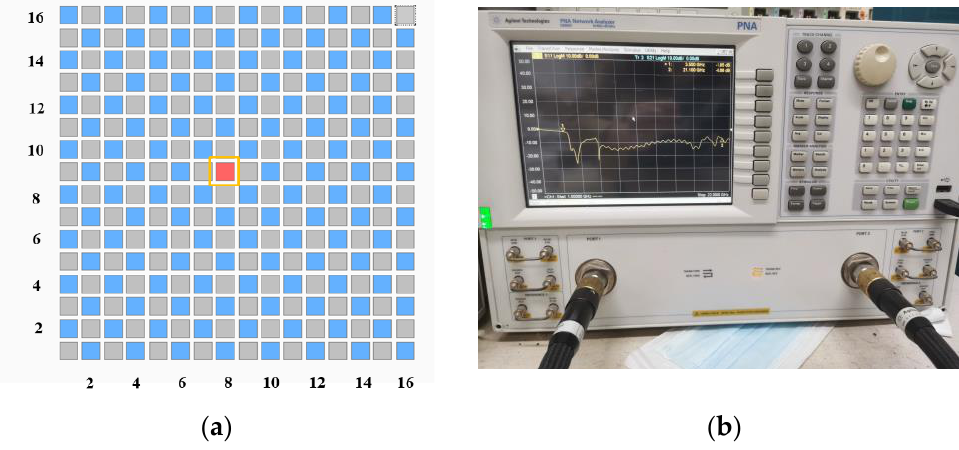
Figure 4. ( a ) Measurement indication for elements of one polarization (red and blue squares) with ports (9,8) excited while the other terminated (grey squares indicate constantly terminated ports); ( b ) measurement scene for the passive reflection coefficient of port (9,8).